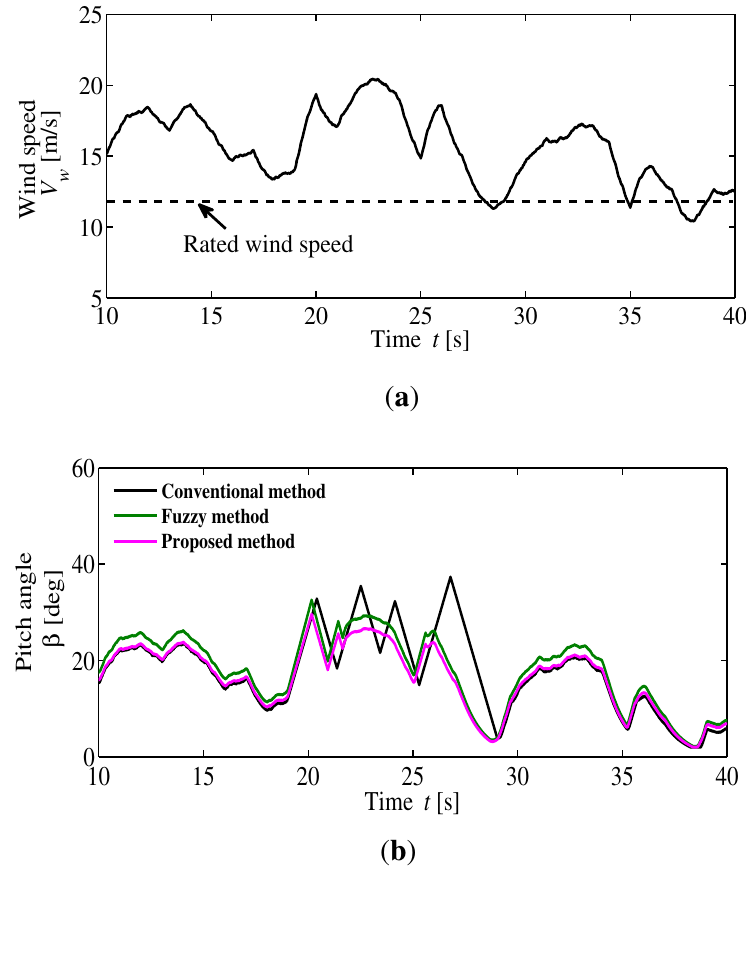
Figure 15. Simulation Results (high turbulence wind speed). ( a ) Wind speed; ( b ) Pitch angle; ( c ) q -axis voltage command; ( d ) d -axis voltage command; ( e ) Output power of PMSG; ( f ) Torque difference; ( g ) DC-link voltage; ( h ) DC-link current; ( i ) Output power of grid-side